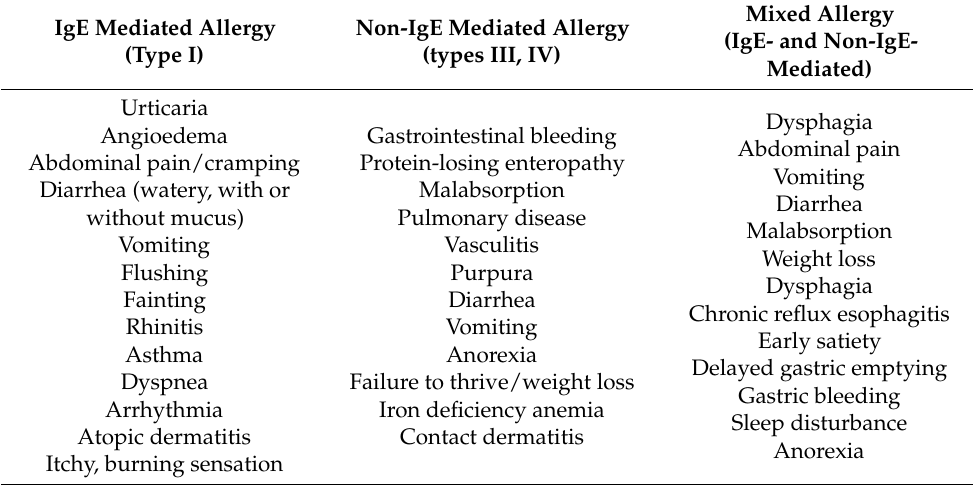
Table 1. Most common symptoms of cow’s milk allergy, based on immunological background. IgE Mediated Allergy (Type